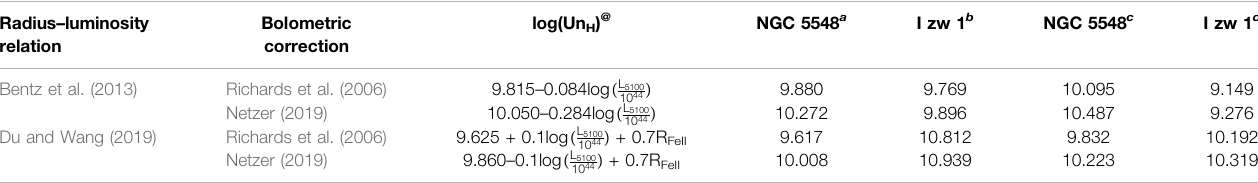
@ denotes the case with χ = 0.5 which is used to estimate values for NGC 5548 and I Zw 1 in columns 4 and 5, respectively. AGN optical luminosity at 5100 Å (L 5100 ) for: a NGC 5548 = 1.66 × 10 43 erg s − 1 (Fausnaugh et al., 2016); and b I Zw 1 = 3.48 × 10 44 erg s − 1 (Persson, 1988). These are consistent with their respective SEDs considered in this article.